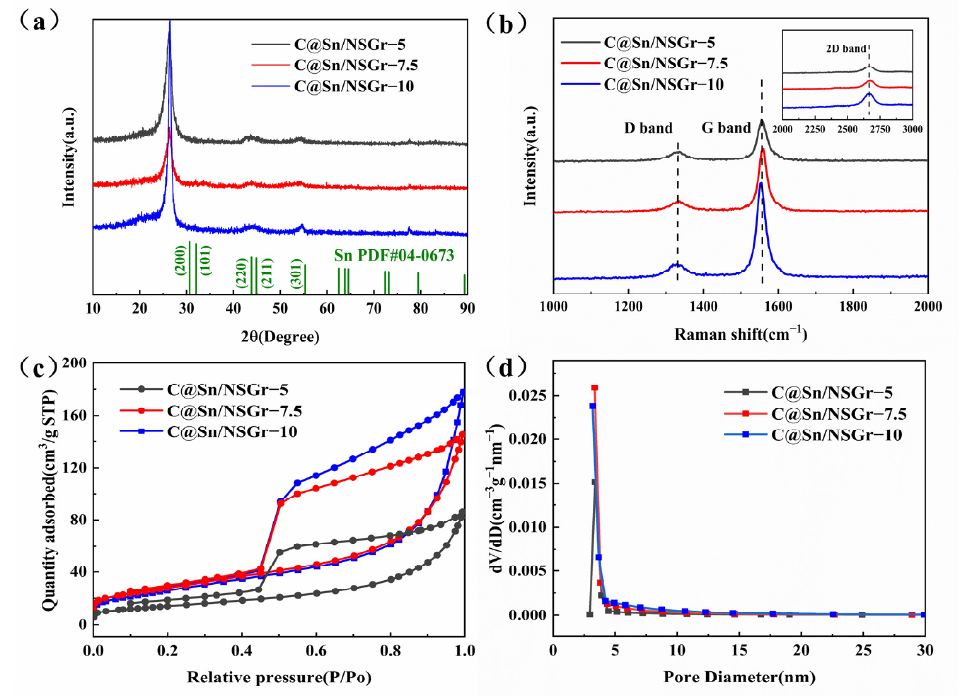
Figure 1. XRD patterns ( a ), Raman spectra ( b ), nitrogen adsorption–desorption isotherm ( c ) and pore diameter distribution ( d ) of C@Sn/NSGr–5, C@Sn/NSGr–7.5 and C@Sn/NSGr–10.